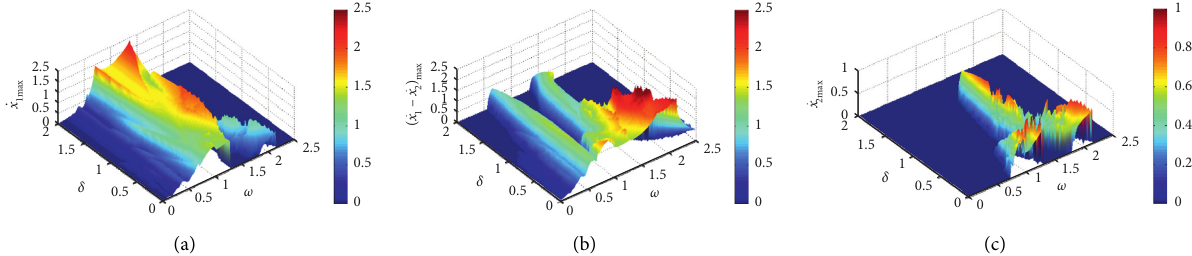
Figure 3: Three-dimensional surface diagrams of the maximum impact velocity of the system associated with each constraint. (a) Constraint A 1 ; (b) constraint A 12 ; (c) constraint A 2 .